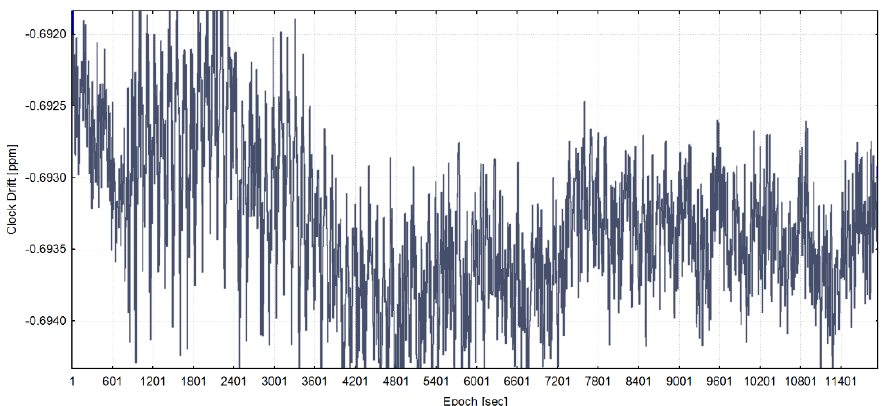
Figure 7. Receiver clock drift from the training dataset with a programmed 0.3 ns / s of time pulling (adapted from [13]).